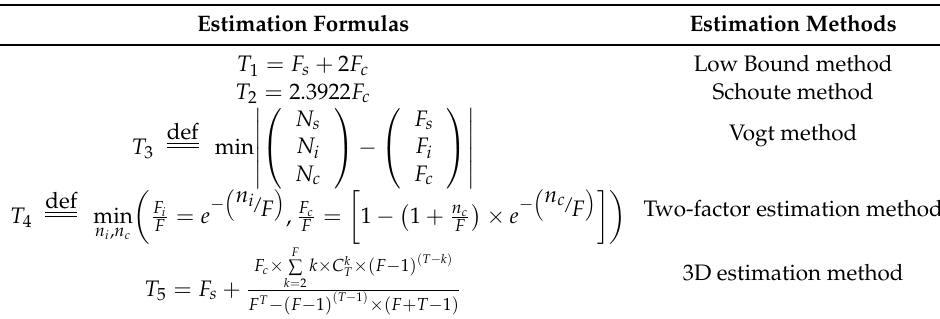
Table 2. Tag estimation